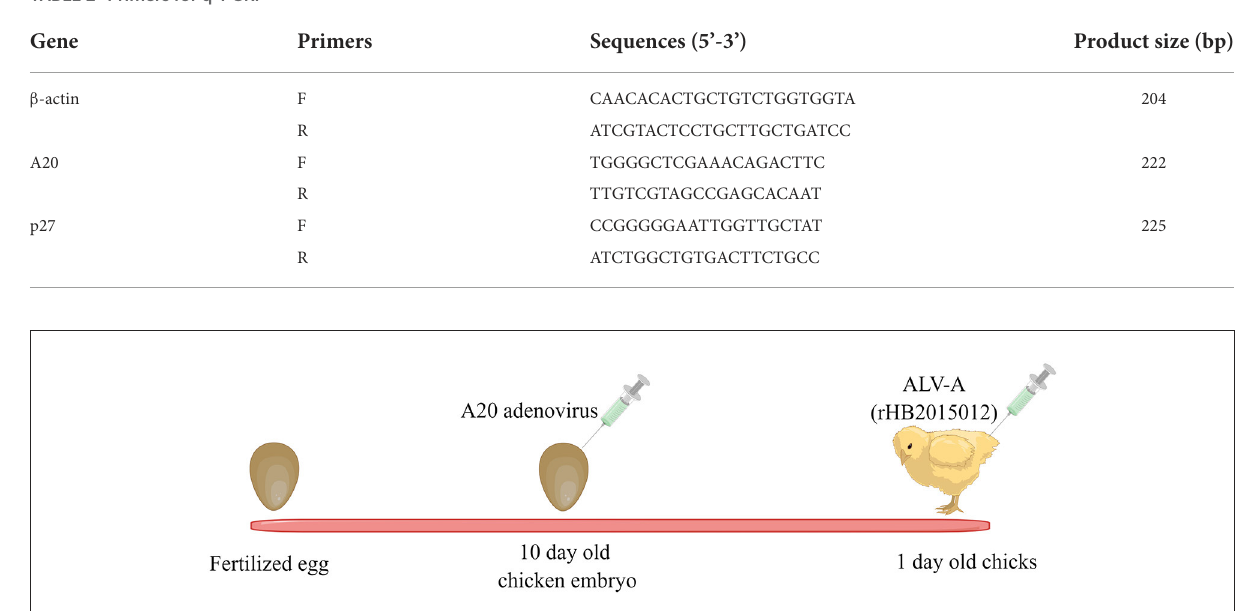
TABLE 2 Primers for q-PCR.